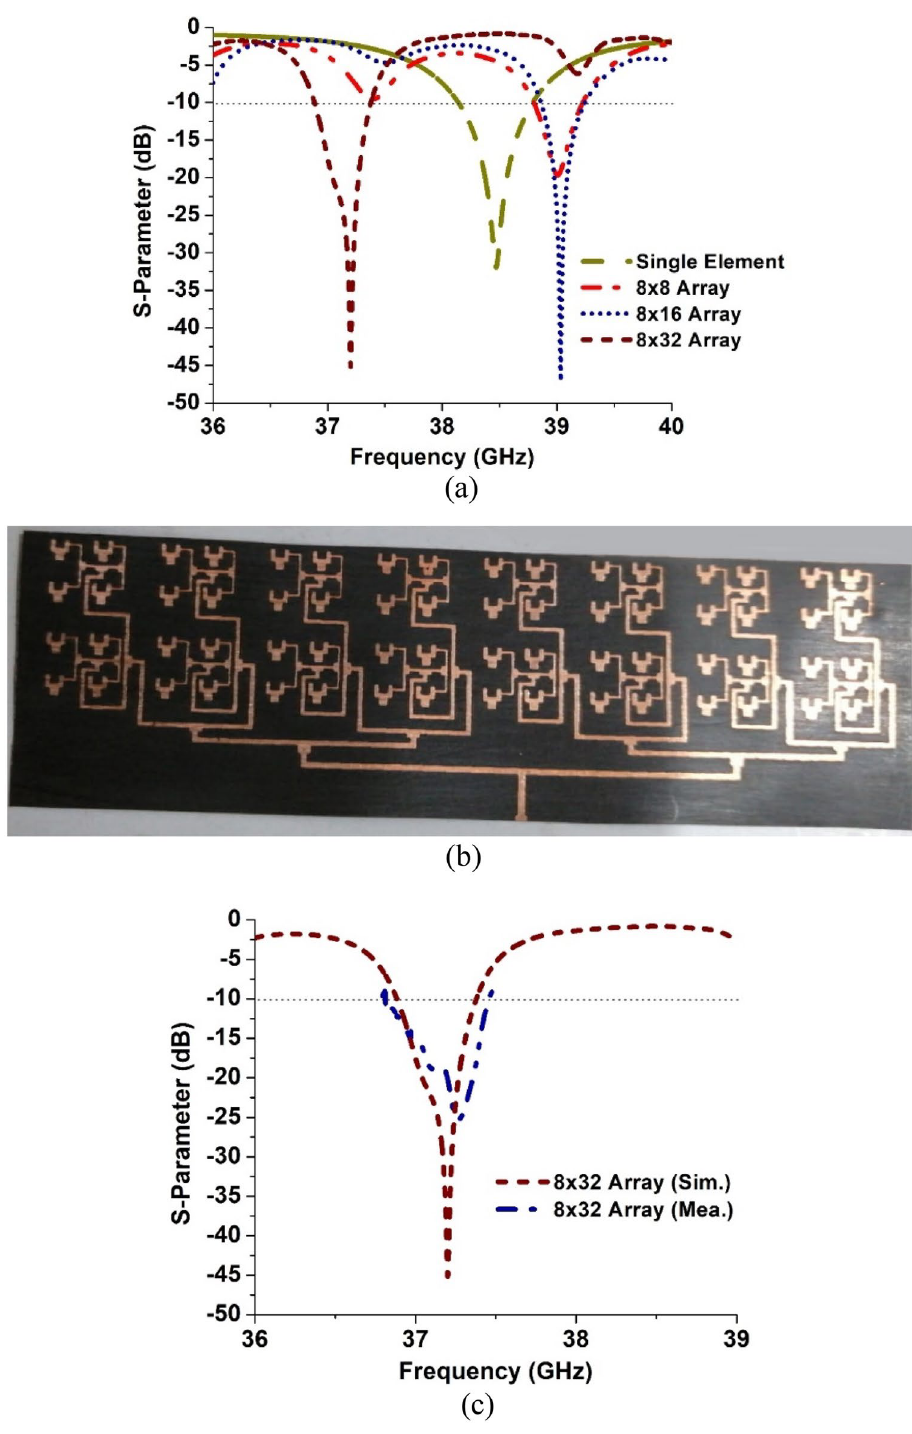
Figure 4. Reflection coefficient comparison of the three antenna array designs, ( a ) simulated, ( b ) photograph of the fabricated 8 × 32 array, and ( c ) measured results of the 8 × 32